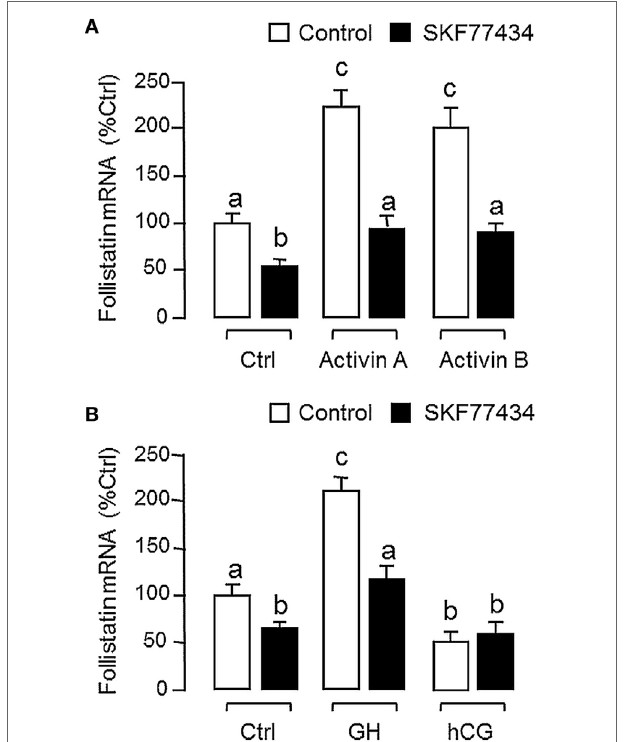
FigUre 6 | Follistatin regulation by activin, growth hormone (GH), and human chorionic gonadotropin (hCG) and their interaction with dopaminergic D1 stimulation in grass carp pituitary cells. (a) Dopamine (DA) D1 activation on activin-induced follistatin mRNA expression. Pituitary cells were incubated for 24 h with activin A (10 ng/ml) or B (10 ng/ml) in the presence or absence of the D1 agonist SKF77434 (1 µM). (B) DA D1 activation on the differential effects of GH and hCG on follistatin mRNA expression. Pituitary cells were exposed to GH (30 ng/ml) or hCG (30 IU/ml) for 24 h with/without the co-treatment of the D1 agonist SKF77434 (1 µM). After drug treatment, total RNA was isolated and subjected to real-time PCR for follistatin mRNA measurement. Data presented are pooled from four experiments ( N = 4) and the groups denoted by different letters represent a significant different at P <